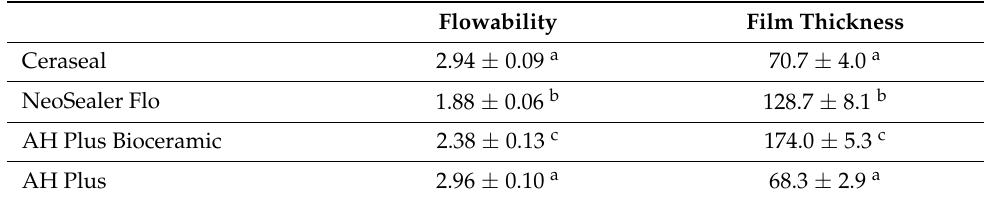
Table 2. Flowability (min, mean ± SD; n = 3) and film thickness ( µ m, mean ± SD; n = 3) of just extruded sealers. Different superscript letters (vertical row) indicate statistically significant differences ( p < 0.05) among